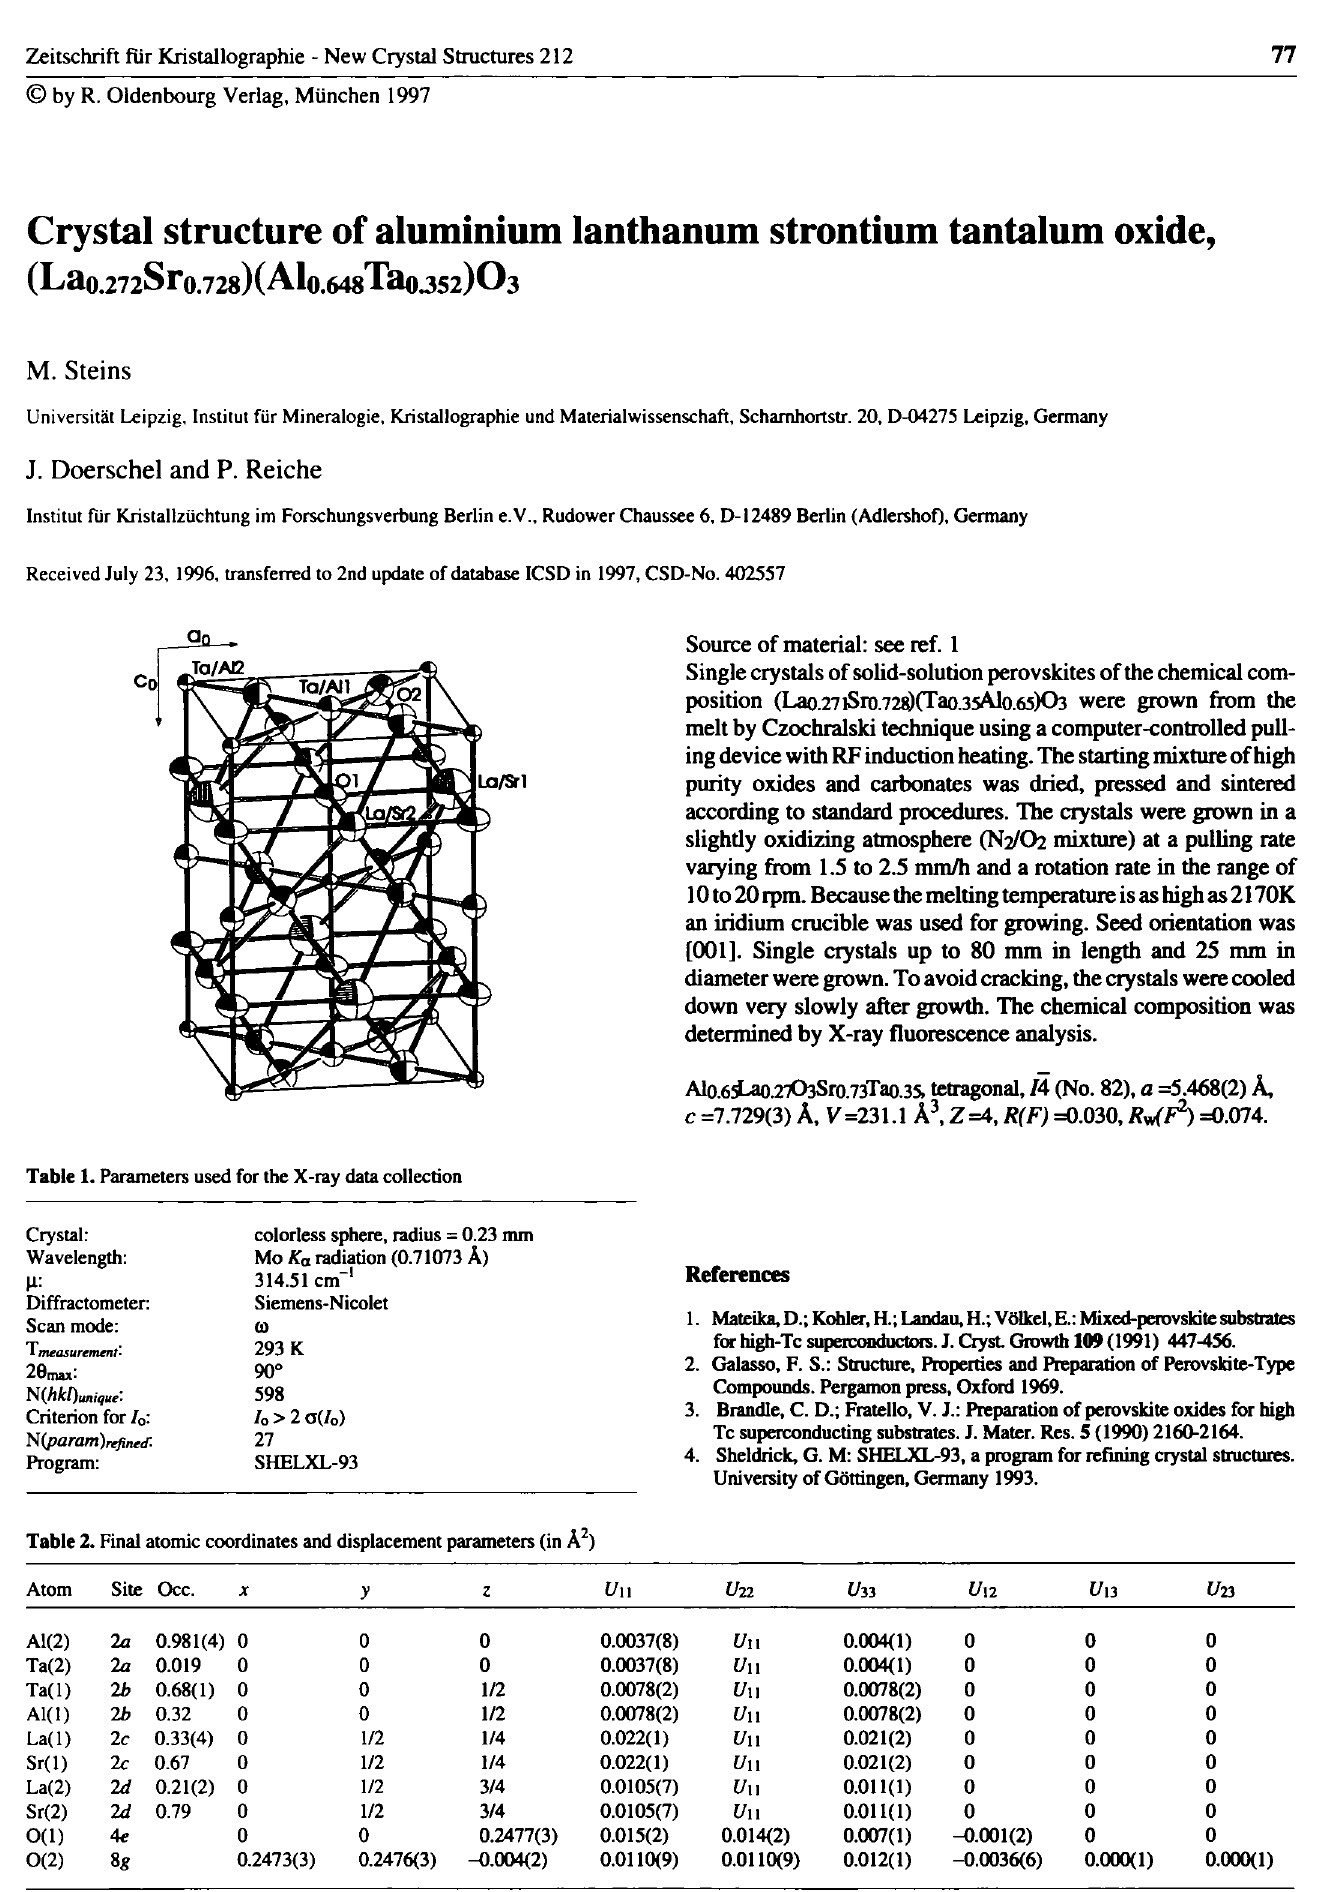
Table 2. Final atomic coordinates and displacement parameters (in À 2